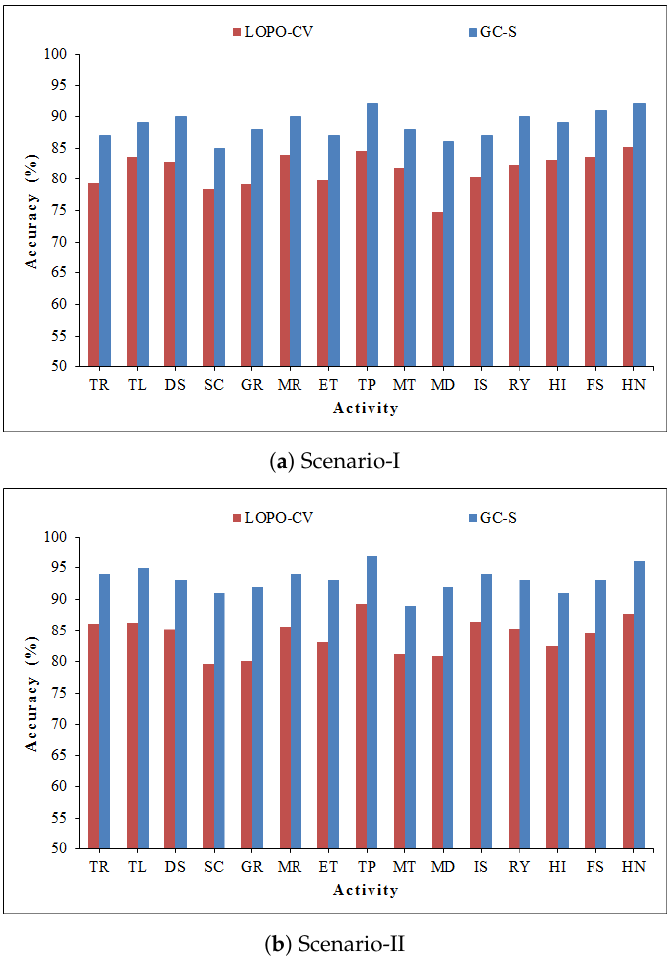
Figure 15. Accuracy test using LOPO-CV scheme.